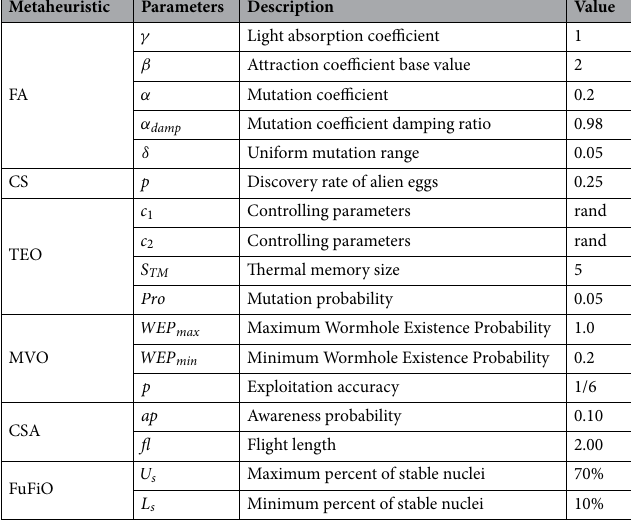
Table 4. Summary of parameters associated with the methods used for comparative